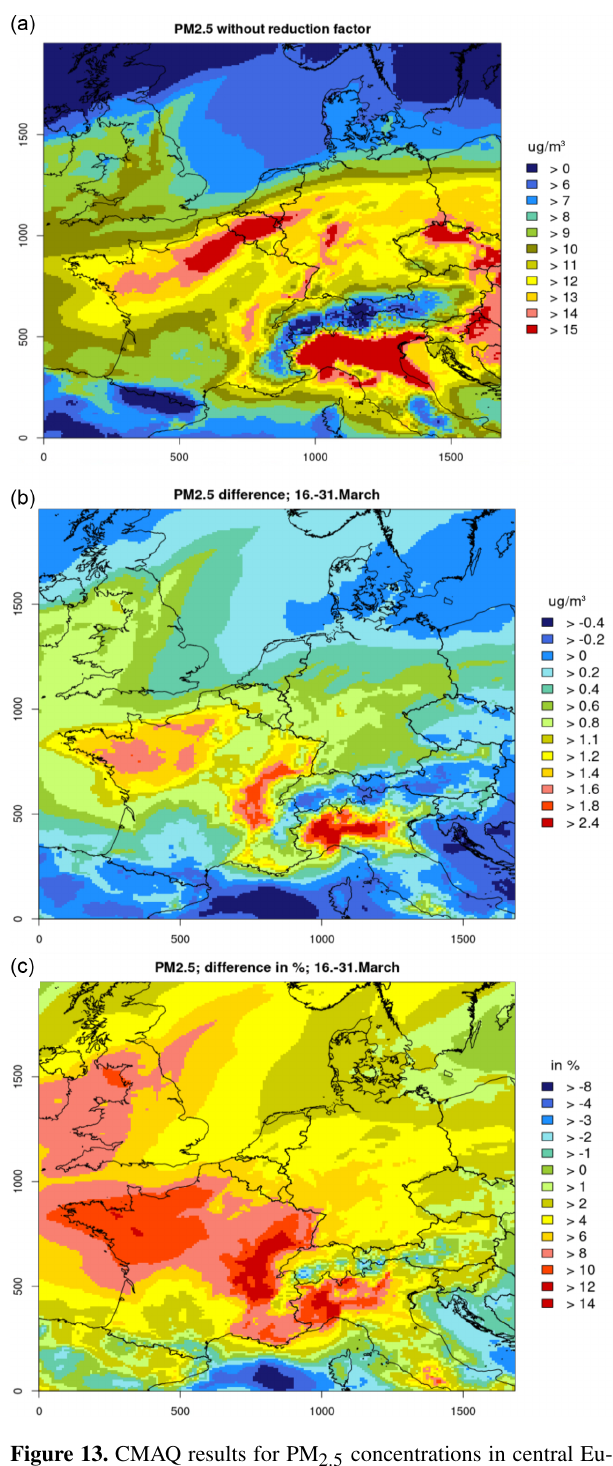
Figure 13. CMAQ results for PM 2 . 5 concentrations in central Eu- rope between 16 and 31 March 2020. (a) Concentrations without lockdown measures (noCOV run). (b) Absolute concentration re- ductions due to lockdown measures (noCOV – COV run); positive values denote reductions. (c) Relative concentration reductions due to lockdown measures (noCOV – COV run); positive values denote